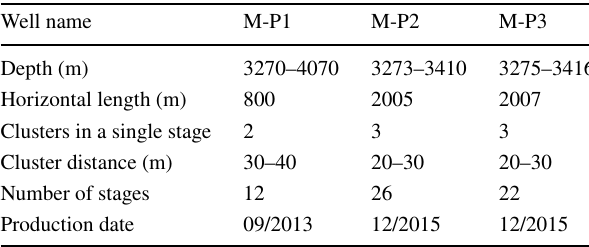
Table 1 Horizontal well configuration and fracturing parameters